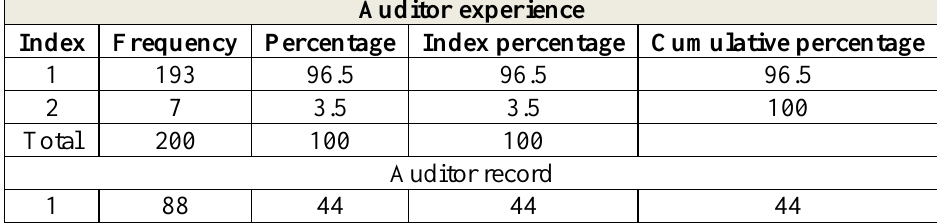
Table 3. Descriptive statistics of Iran and